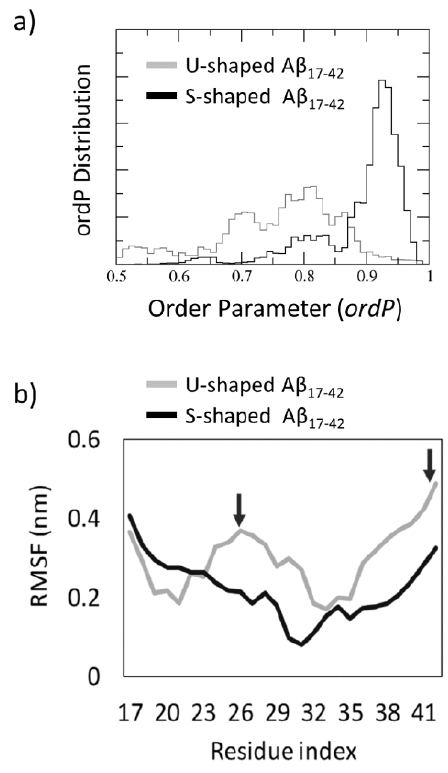
Figure 4. ( a ) Order Parameter, ordP, distribution calculated throughout the overall REMD trajectory at 300 K. The same number of snapshots was considered for both U-shaped (grey line) and S-shaped (black line) models. The ordP value provides a quantitative estimation of the fibril order. Values close to 1 indicate an alignment close to the starting structure, i.e., aligned fibre along the fibril axis. Values lower than 1 indicated a structure distortion; ( b ) Root Mean Squared Fluctuation (RMSF) plot calculated over the REMD trajectory at 300 K filtered on the ensemble weighted Maximally Correlated Motion (ewMCM) vector. Black arrows indicate residues with the highest RMSF in central and C-terminal regions of the U-shaped model.